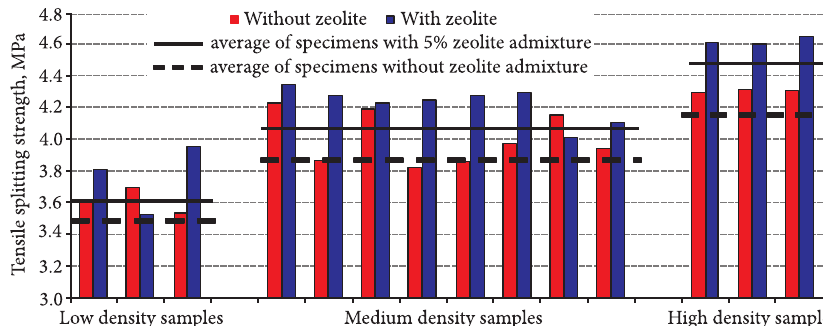
Fig. 7. Tensile splitting strength of paving blocks after 7 days of